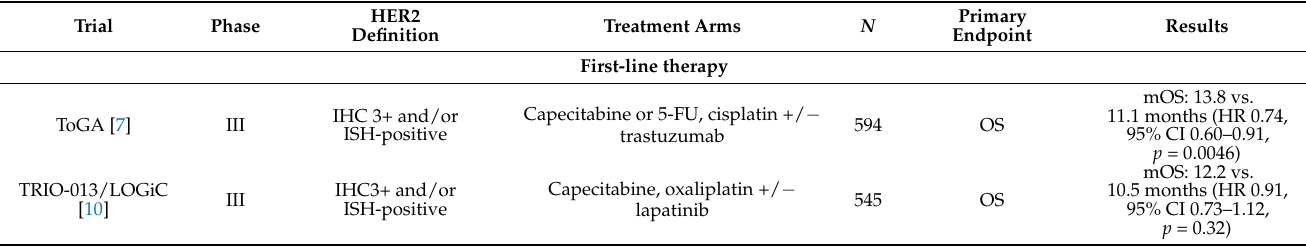
Table 1. Selected randomised HER2-targeted clinical trials in advanced oesophago-gastric adenocar- cinoma. Adapted from